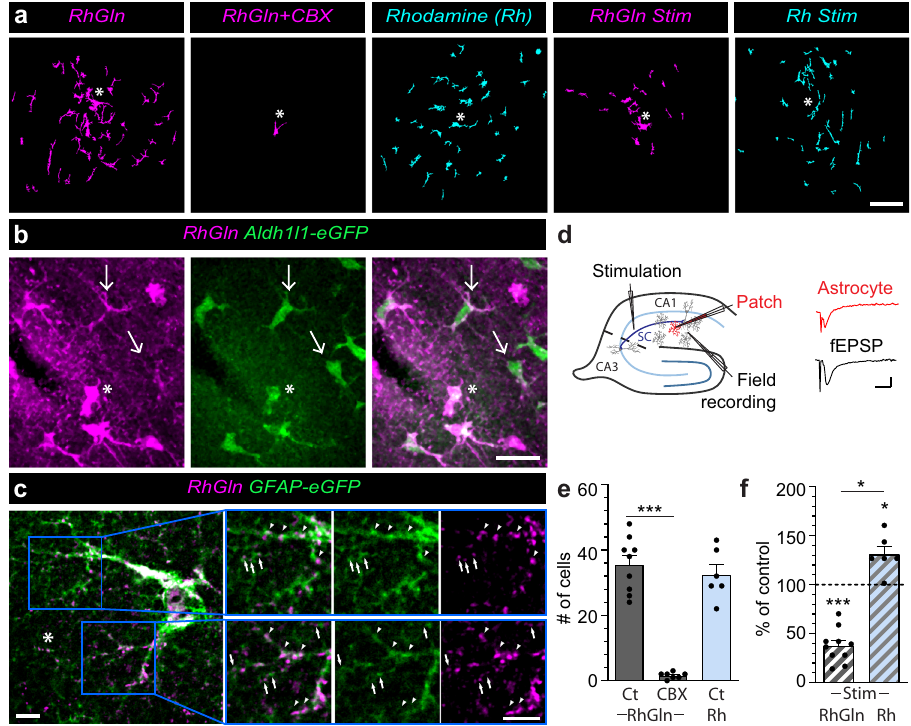
Fig. 2 RhGln reveals activity-dependent redistribution of glutamine away from astroglial networks. a RhGln or Rh traf fi cs through gap junction-mediated astroglial networks when dialyzed (0.8 mM, 20 min) into a single CA1 hippocampal astrocyte via the patch pipette. The representative images illustrate the transfer of RhGln (magenta) or Rh (cyan) from the patched astrocyte (asterisks) to neighboring cells under control condition, which was abolished by the gap-junction blocker carbenoxolone (CBX, 200 μ M), and reduced by repetitive synaptic stimulation (Stim; 10 Hz, 30 s every 3 min for 20 min). The transfer of Rh was similar to RhGln in basal condition, but was not reduced by stimulation. b RhGln under control conditions was found distributed in neighboring cells identi fi ed as Aldh1l1-positive astrocytes (green), indicating the spread of glutamine into astroglial networks. Asterisks mark the position of the patched cell. Thin arrows mark astrocytes in which RhGln-labeling is found primarily in processes. c RhGln puncta were observed along main (arrowheads) and fi ne processes (arrows) of a GFAP-positive cell (green). Higher magni fi cation of two areas (blue boxes) are also shown. d Schematic and sample traces showing simultaneous recordings of evoked depolarization of a patched astrocyte (Patch, red trace) and fi eld excitatory postsynaptic potential (fEPSP, Field recording, black trace) during stimulation of the Schaffer collaterals (Stimulation). e Quanti fi cation of RhGln or Rh transfer from the patched astrocyte to neighboring cells under different conditions (Control, Ct-RhGln, n = 9; CBX-RhGln, n = 7, p < 0.0001; Ct-Rh, n = 6, p = 0.7745; one-way ANOVA with Bonferroni ’ s post hoc test with Ct-RhGln). f Quanti fi cation of RhGln or Rh transfer from the patched astrocyte to neighboring cells under stimulated conditions normalized to control (Stim-RhGln, n = 10, p < 0.0001; Stim-Rh, n = 6, p = 0.0123; one-sample t -test with 100%; p = 0.0421 two-tailed un p aired Student ’ s t -test between Stim-RhGln and Stim-Rh). Mean ± SEM in e , f . Scale bars: a 50 µ m; b 20 µ m; c 5 µ m; d 0.5 mV (Astrocyte), 0.2 mV (fEPSP), 20 ms. Asterisks indicate statistical signi fi cance (*** p < 0.0001, * p < 0.05). Representative images in a , b are from replicates described in e and f ; and c are from n = 3 replicates. Source data are provided as a Source data fi